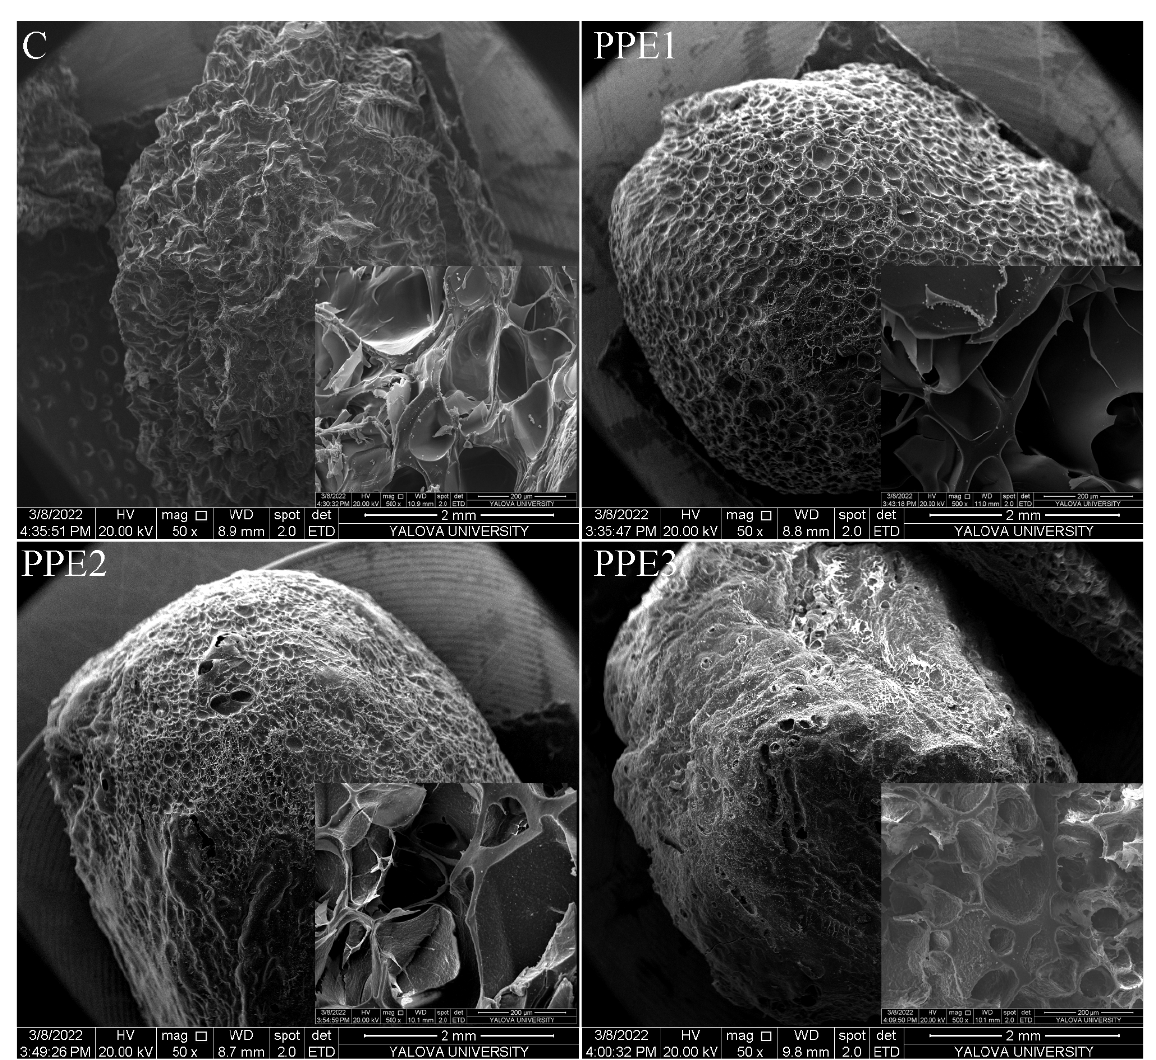
Figure 5. Scanning electron microscope (SEM) images of “Boba balls”. (C: Control, “Boba balls” without pomegranate peel extract (PPE); PPE1: “Boba balls” containing 1% PPE; PPE2: “Boba balls” containing 2% PPE; PPE3: “Boba balls” containing 3% PPE).